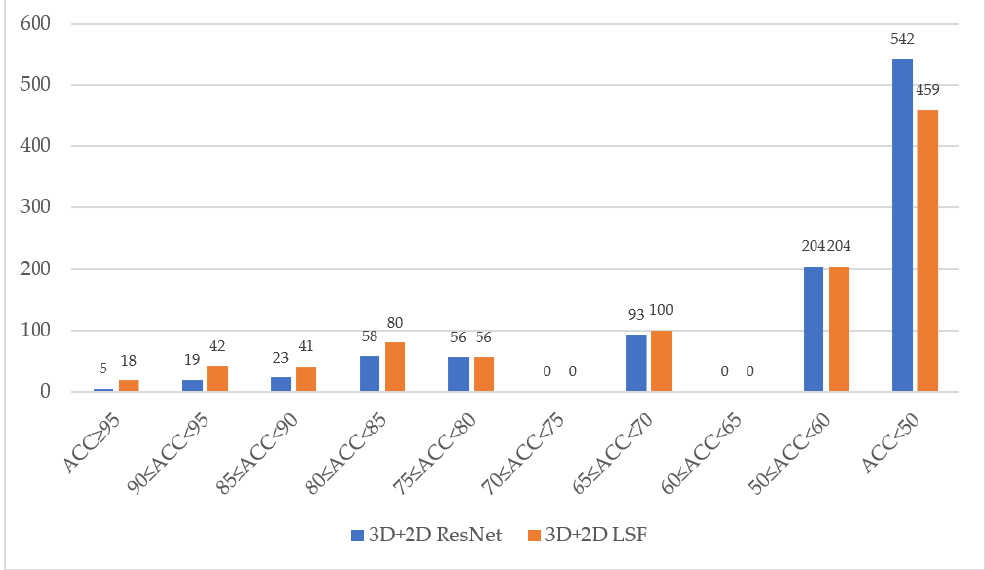
Figure 8. Statistics of accuracy for each class in LRW-1000. The blue histogram is the baseline model we compared, while the orange histogram is LSF.